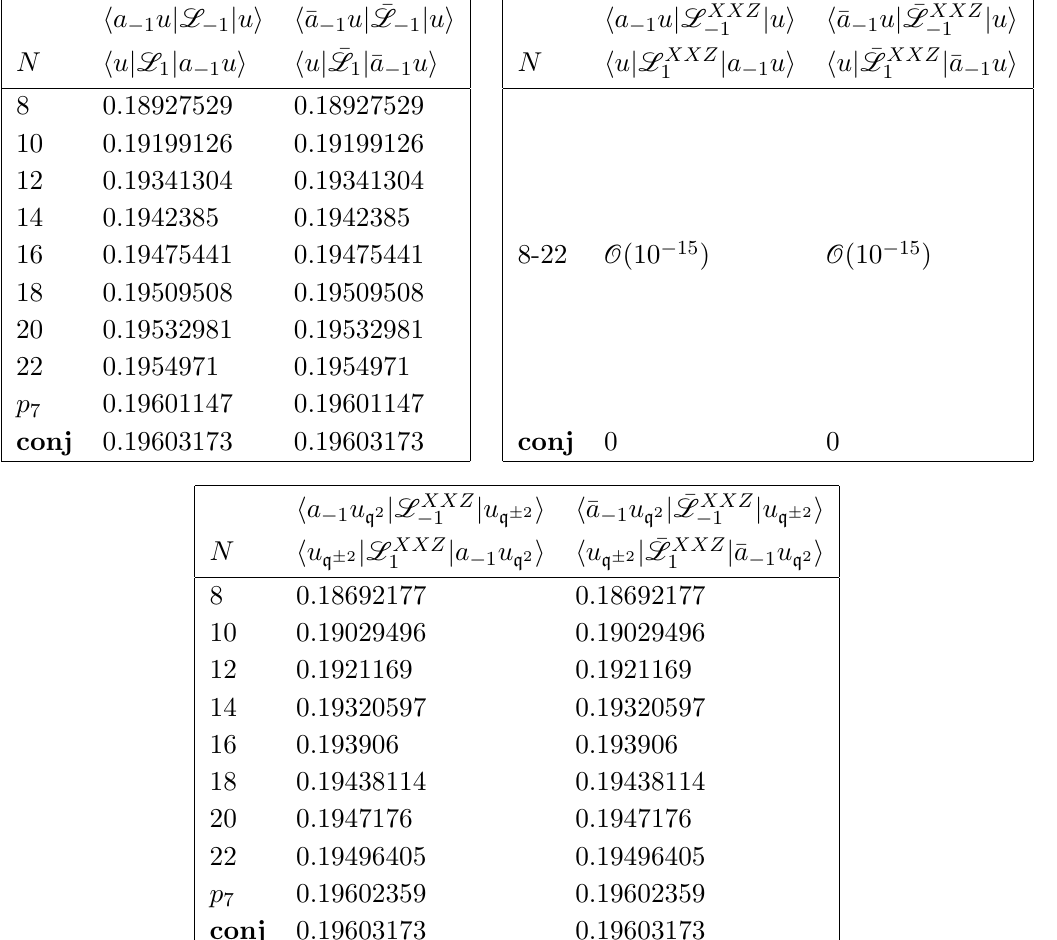
Table 12 . Matrix elements of L (cid:6) 1 , (cid:22) L (cid:6) 1 , L XXZ table 3, in the sector of S z = 0 at x = (cid:25) . We call j u i the primary state at e = 0 and periodic boundary conditions e (cid:30) = 0 corresponding to the module W 0 ; 1 (top), and j u at j e j = 1 and twisted boundary conditions j e (cid:30) j = (cid:0) (cid:11) (cid:0) =(cid:11) + corresponding to the modules W and W (bottom) for which the results are the same. In the latter case, the results for L (cid:6) 1 and 0 ; q (cid:0) 2 (cid:22) L (cid:6) 1 are given in table